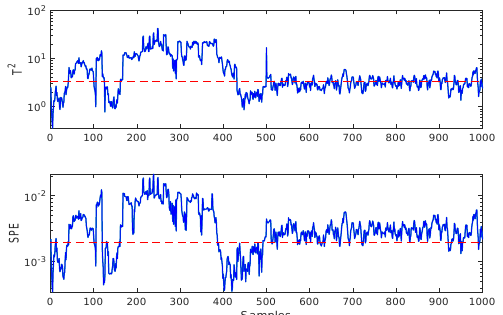
Figure 5. Experiment results of the FD model using